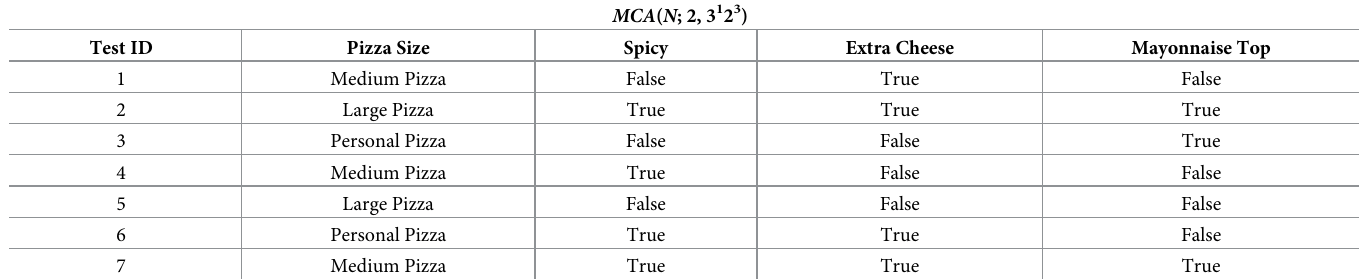
Table 1. Mapping of mixed covering arrays to test